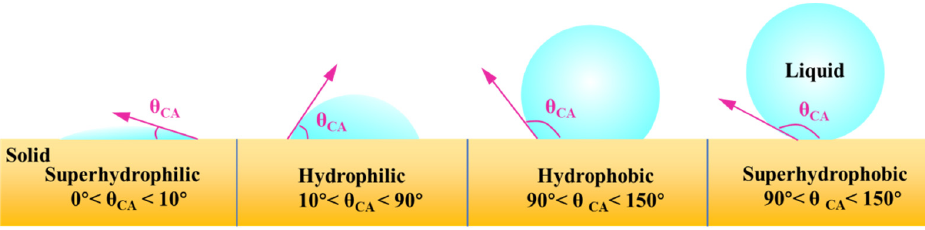
Figure 2. Four wetting conditions.